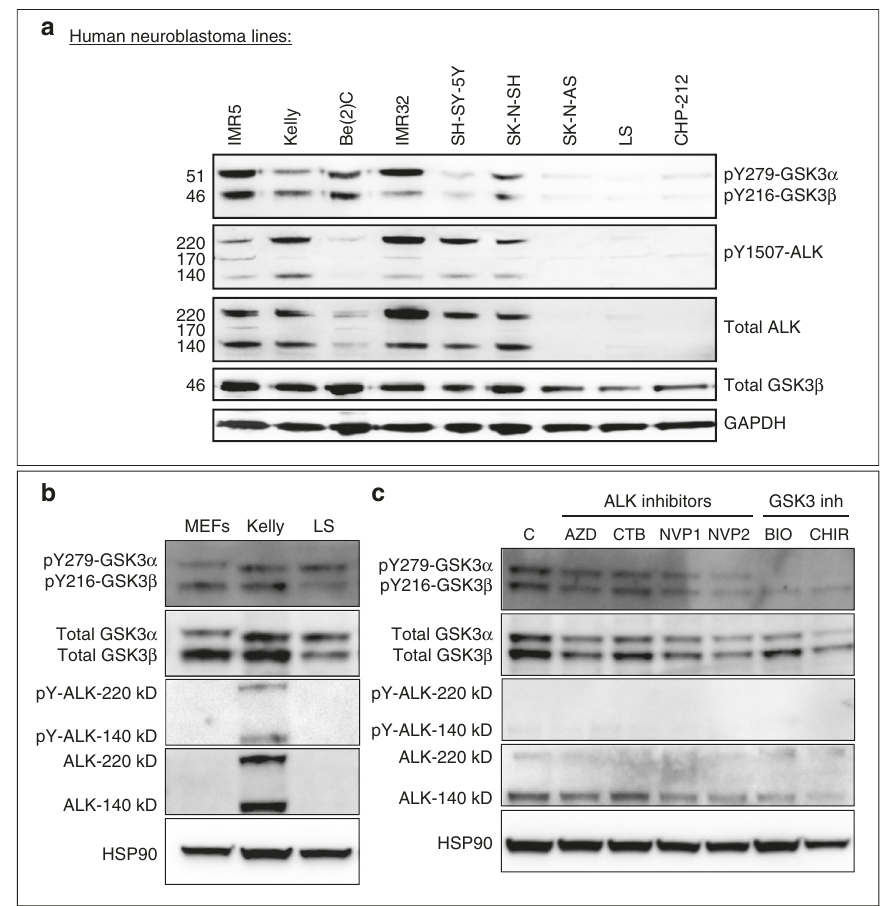
Fig. 7 Neuroblastoma lines with high levels of active ALK also have high levels of pY-GSK3. a Western blotting of neuroblastoma lines reveals levels of pY- GSK3 correlates with levels of ALK-pY1507 (IMR5, Kelly, Be(2)C, IMR32, SH-SY-5Y, SK-N-SH). Cell lines with low or no ALK-pY1507 (SK-N-AS, LS, CHP- 212) have correspondingly low levels of pY-GSK3. b Western blotting showing that only Kelly cells have high levels of ALK when compared to mouse embryonic fi broblasts (MEFs) and LS neuroblastoma cells. c Western blotting analysis reveals that, in Kelly cell line, ALK inhibition with NVP-TAE, results in gradual loss pYGSK-3 α and pYGSK-3 β , are signi fi cantly reduced after 24 h treatment with NVP-TAE, GSK3 inhibition, using BIO or CHIR, leads to a reduced expression of pY-GSK3, more predominantly is pY-GSK3 α isoform. Some loss of ALK is also seen in NVP treatments. Treatments used were 1.5 µ M crizotinib, 1.5 µ M AZD-3463, 1 µ M NVP-TAE-684 (NVP1), 2 µ M NVP-TAE-684 (NVP2), 0.5 μ M BIO and 1.0 μ M CHIR99021 Fig. 6 Inhibition of ALK leads to decreased levels of pY-GSK3 in mouse neural crest. a – f ALK is expressed in the neural crest. ( a , d ) mRNA in situ hybridization for Alk in e8.5 and e9.5 mouse embryos. b , c , e , f Antibody staining for activated ALK protein shows expression at the neural plate border (red arrows) and in the branchial arches. g Staining for total ALK (green). g Very little total ALK is present in the neural plate with some present at the edge of the premigratory neural crest (white arrowheads). h Migratory neural crest cells express higher levels of ALK. i In fully migratory NC cells, ALK appears to be nuclear. Underneath each panel, ALK merged with Hoechst. j Co-immunostaining of pY-GSK3 (green) and ALK (red) show that ALK is expressed in all cells that express pY-GSK3. k Treatment with the ALK inhibitor crizotinib (CTB) for 24 h reduces the levels of pY-GSK3. l , m , n , o Quantitation of loss of pY-GSK3 and ALK fl uorescence using the alternative inhibitor NVP-TAE also results in a loss of mean fl uorescence intensity. p – s Bright- fi eld images of neural crest explants treated with vehicle control or three different ALK inhibitors: 1.5 µ M CTB, 1.5 µ M AZD-3463, or 1 µ M NVP-TAE-684. All three treatments showed a loss of migratory neural crest (red dotted lines) ( n = 3 explants with ≥ 10 cells per explant, scale bar = 500 µ m). t Area quanti fi cation of the premigratory neural crest (pNC, area depicted by blue dotted lines covered in p – s ) and the migratory neural crest population (mNC, red dotted lines). A signi fi cant reduction in mNC was seen in AZD and NVP treated explants. u – y Phalloidin staining shows F-actin structure in explants. Hoechst marks nuclei. Note the loss of lamellipodial structures upon ALK inhibition ( w , x ) is comparable to BIO treatment ( v ) (scale bar = 25 µ m). y Percentage of cells with lamellipodial formations at the leading edge upon treatment with GSK3 inhibitor BIO or with ALK inhibitors ( n = 10 – 20 cells per explant). Bars, mean ± SD. One-way ANOVA and unpaired t -test * P < 0.05, ** P <